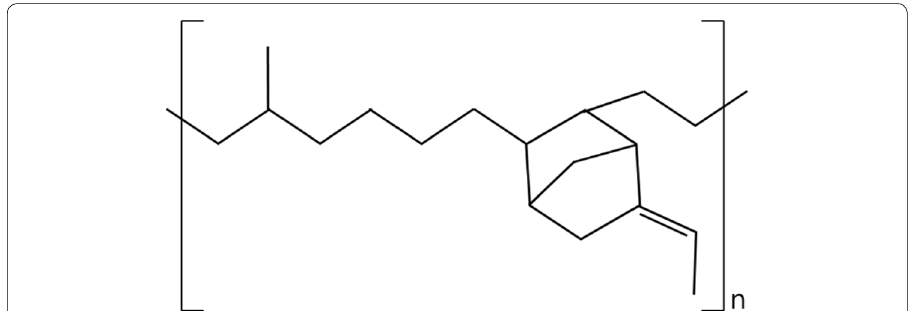
Fig. 1 Chemical structure of bio‑based